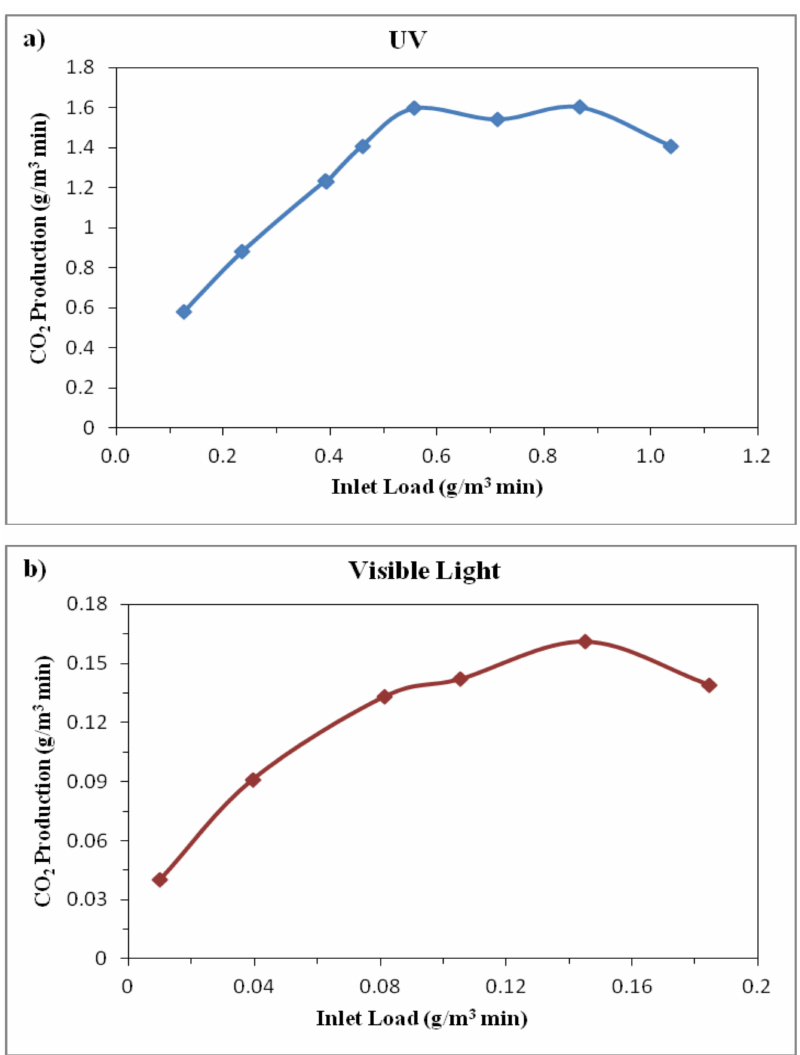
Figure 11. CO 2 production against the ethlylbenzene inlet load in photocatalytic reactions using N-doped TiO 2 catalyst under ( a ) UV and ( b ) visible light